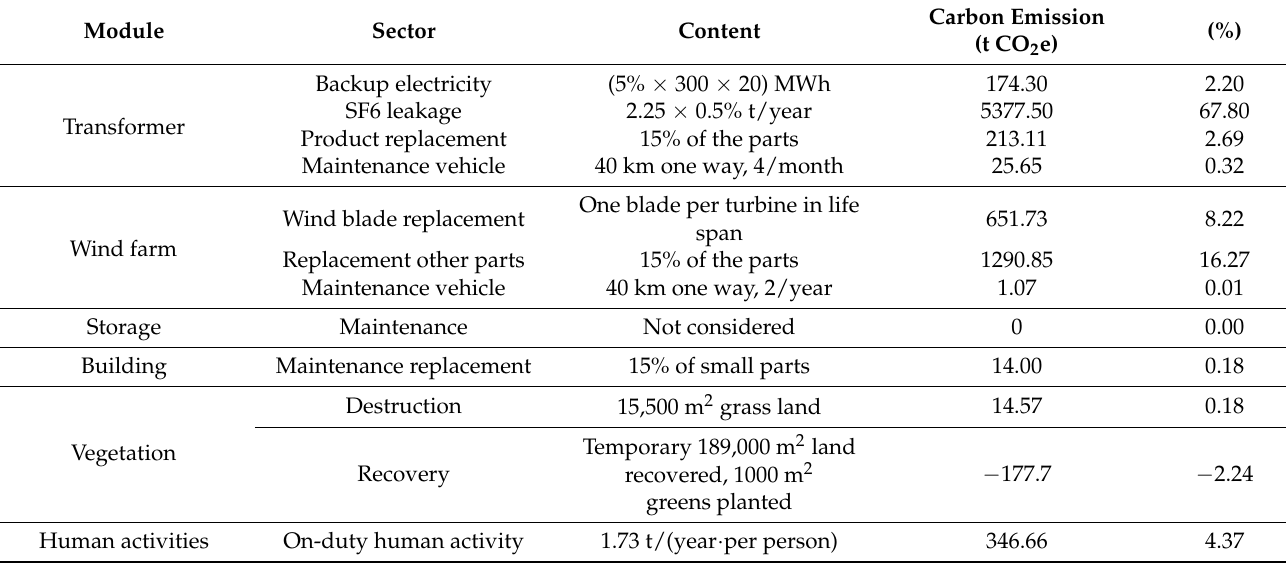
Table 9. Carbon emissions in the operation and maintenance